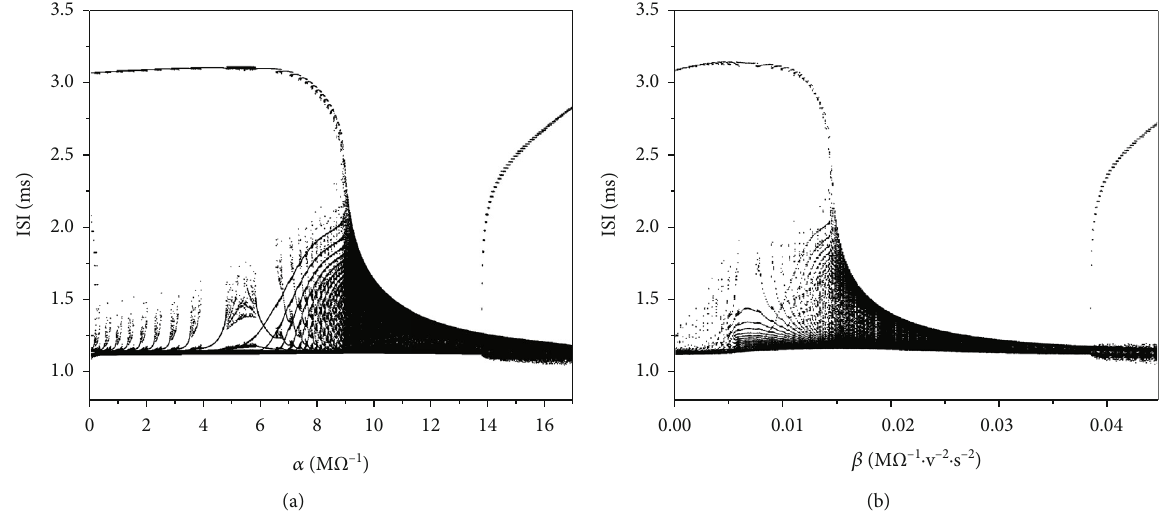
Figure 13: (a) The bifurcation diagram of ISI versus α ; (b) the bifurcation diagram of ISI versus β